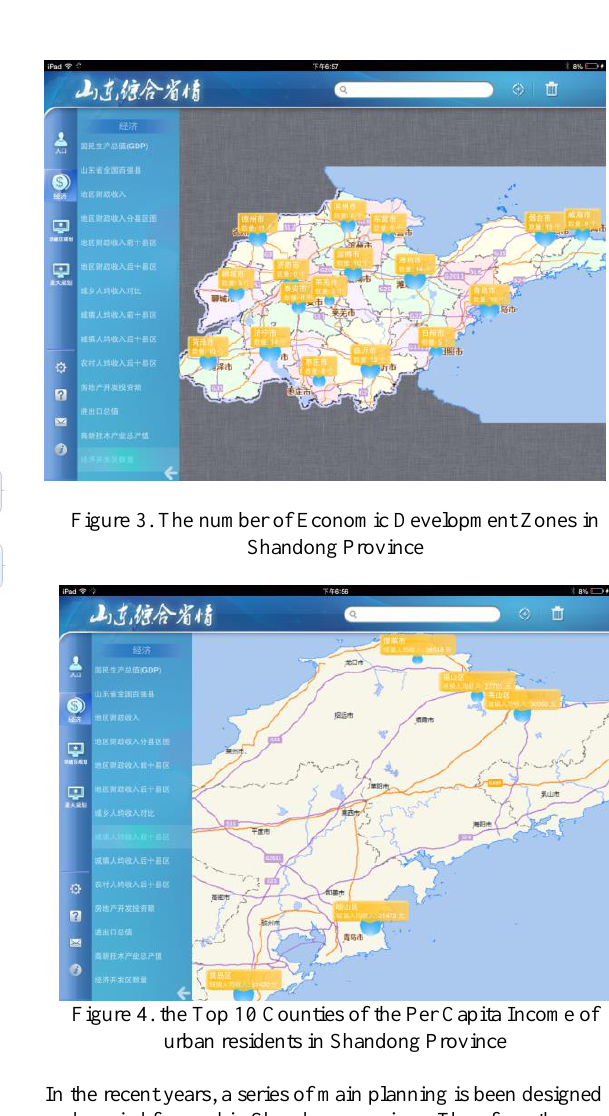
Figure 4. the Top 10 Counties of the Per Capita Income of urban residents in Shandong